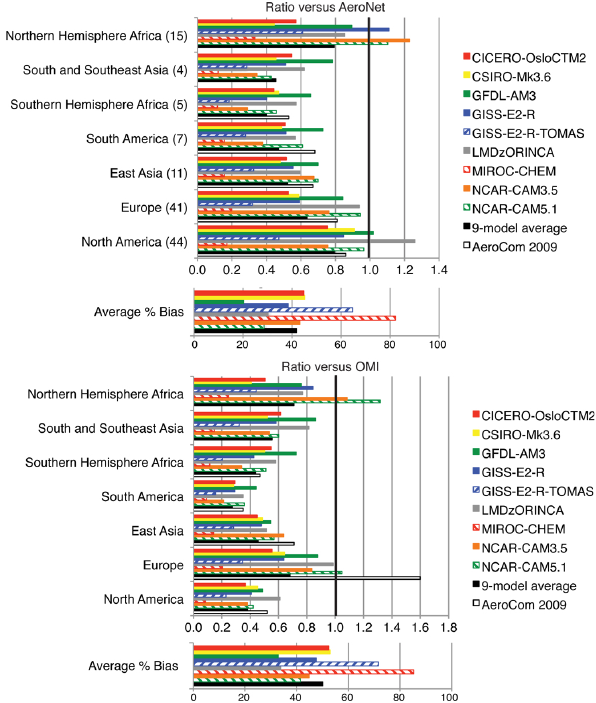
Fig. C1. Ratio of regional average model to retrieved AeroNet (top) and OMI land-area (bottom) clear-sky AAOD at 550nm for the AC- CMIP models. Number of measurement sites is given for AeroNet for each region. The AeroNet data are for 1996–2006, v2 level 2, with annual averages for each year used if more than eight months were present, and monthly averages required more than 10 days of measurements. The values at 550 nm were determined using the 0.44 and 0.87µm Angstrom parameters. Regions are shown in Fig. 6 and are defined as North America (130 to 70 ◦ W; 20 to 55 ◦ N), Eu- rope (15 ◦ W to 45 ◦ E; 30 to 70 ◦ N), East Asia (100 to 160 ◦ E; 30 to 70 ◦ N), South America (85 to 40 ◦ W; 34 to 2 ◦ S), Southern Hemi- sphere Africa (20 ◦ W to 45 ◦ E; 34 to 2 ◦ S), South and Southeast Asia (60 to 110 ◦ E; 10 to 30 ◦ N) and Northern Hemisphere Africa (20 ◦ W to 60 ◦ E; 0 to 30 ◦ N; which includes the Arabian Penin- sula). Also shown is the average of 14 AeroCom models from the analysis of Koch et al. (2009) (except for NH Africa and S/SE Asia, which were not calculated for AeroCom). Average % biases shown at the bottom of each analysis are average absolute values over the 7 regions for a given ACCMIP